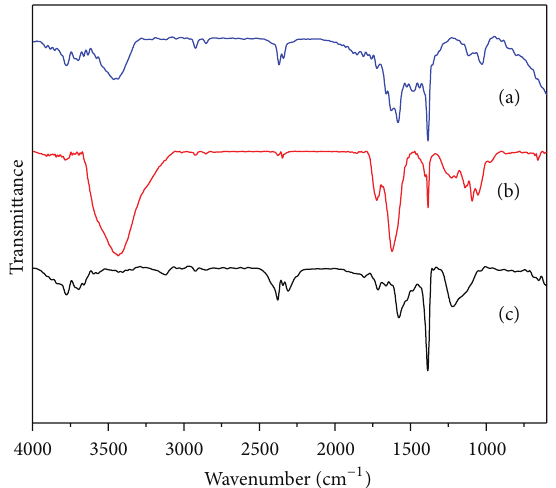
Figure 3: FTIR spectra of (a) graphite, (b) XGO, and (c) RGO.